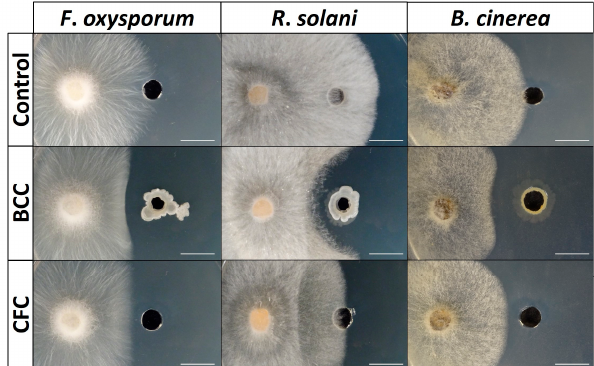
Figure 4. Dual culture assay for mycelial inhibition of the phytopathogenic fungi F. oxysporum , R. solani and B. cinerea by bacterial cell culture (BCC) and bacterial cell-free culture (CFC) with the creation of an inhibition zone (scale bar = 5 mm).